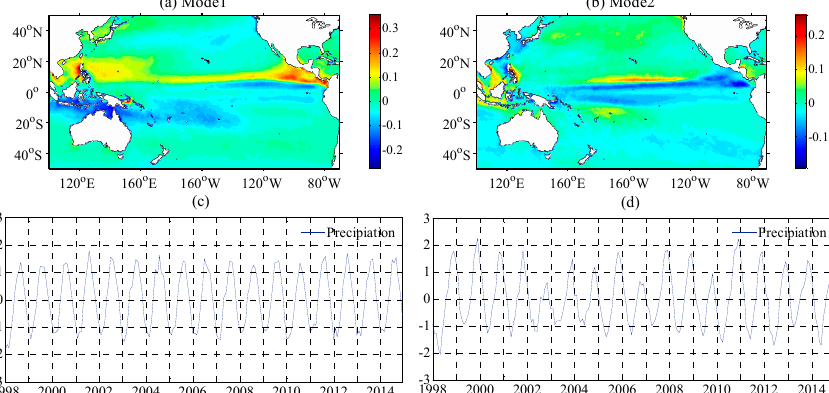
Figure 1. Seasonal variability of precipitation in the Pacific Ocean characterized by the first two empirical orthogonal function (EOF) modes: ( a , b ) are the spatial patterns of EOF modes (Unit: mm/hr); ( c , d ) are the time series of normalized principal components (PC).